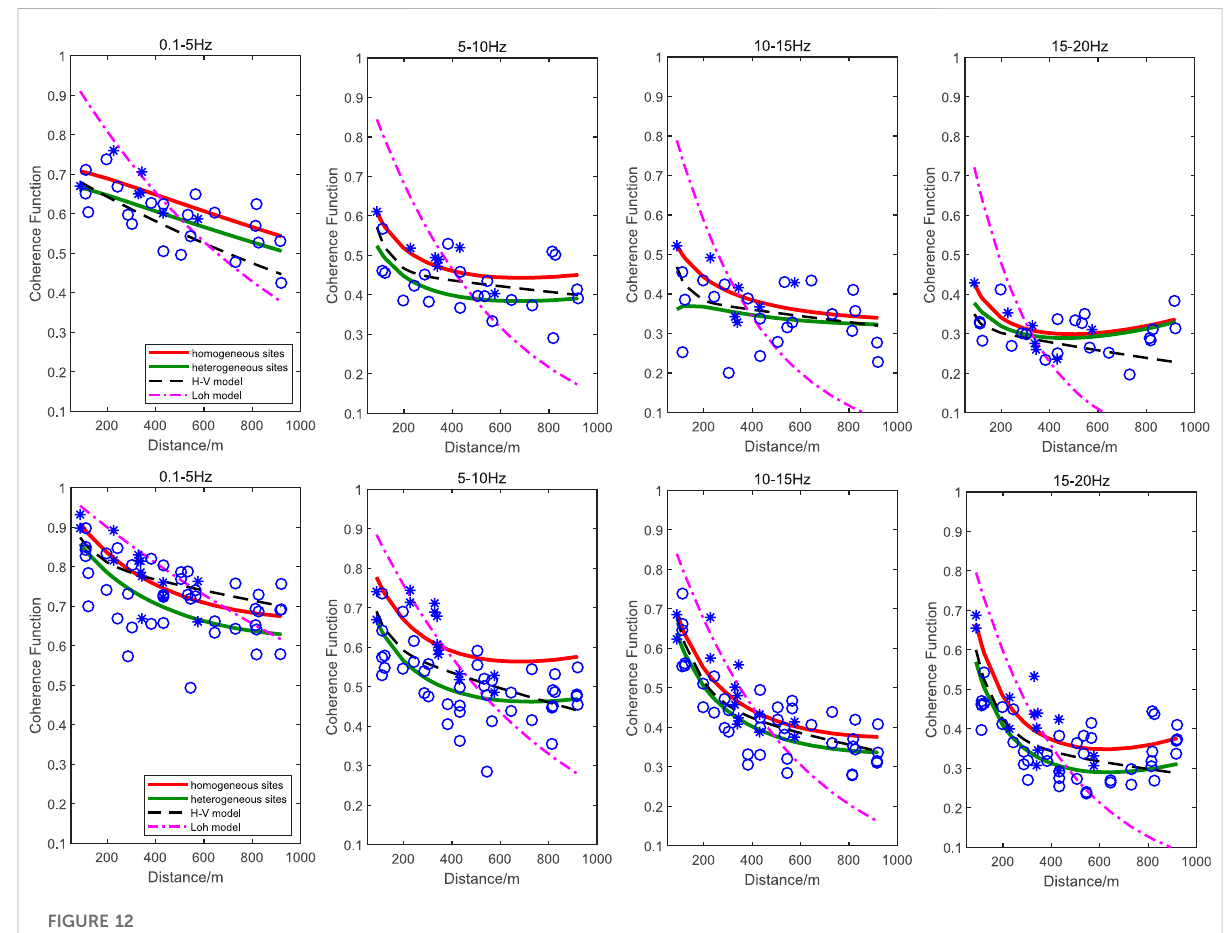
FIGURE 12 Fitting results for the Yibin earthquake: (A) vertical direction and (B) horizontal direction.